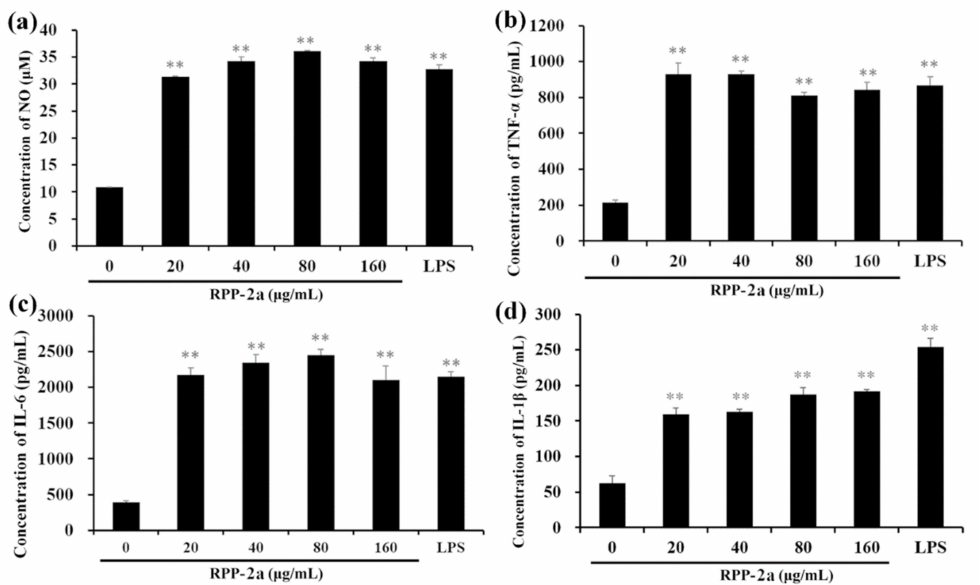
Figure 8. Enhanced effects of RPP-2a on NO and proinflammatory cytokines production. ( a ) NO. ( b ) TNF- α . ( c ) IL-6. ( d ) IL-1 β . Data are presented as mean ± SD; ** = p < 0.01 vs. control group. 2.9. Effects of RPP-2a on the Expression of Inducible Nitric Oxide Synthase (iNOS) and